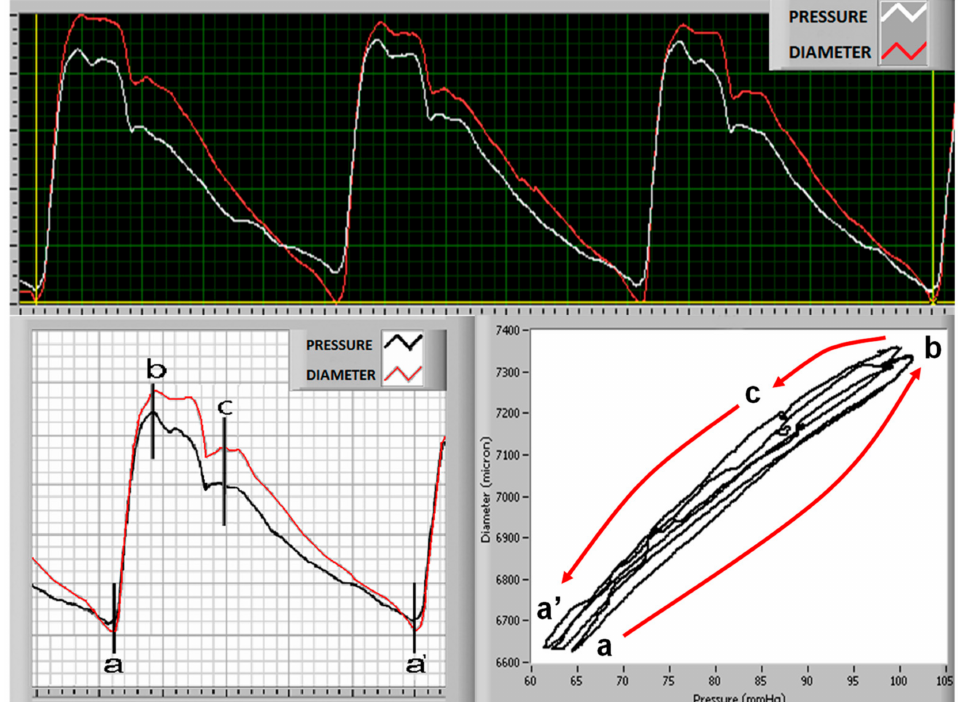
Figure 1. Upper panel: original tracings of carotid diameter (red line) and simultaneously acquired blood pressure (white line) wave. Lower panel: on the left arterial pressure wave (black line) and curves of cross-sectional diameter changes (red line); a–b interval indicates the proto-mesosystolic phase, and c–a’ is the late diastole phase (lower panel). Cross-sectional diameter/pressure curves are shown in the right lower